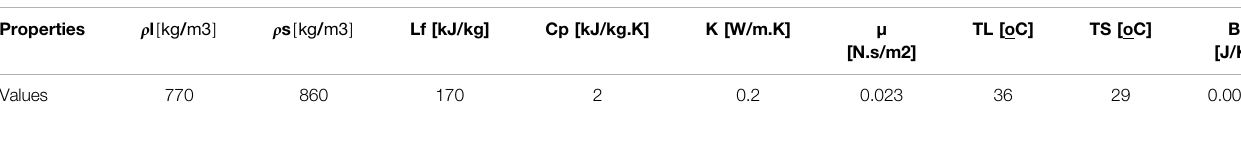
TABLE 2 | Thermodynamic properties of the PCM used